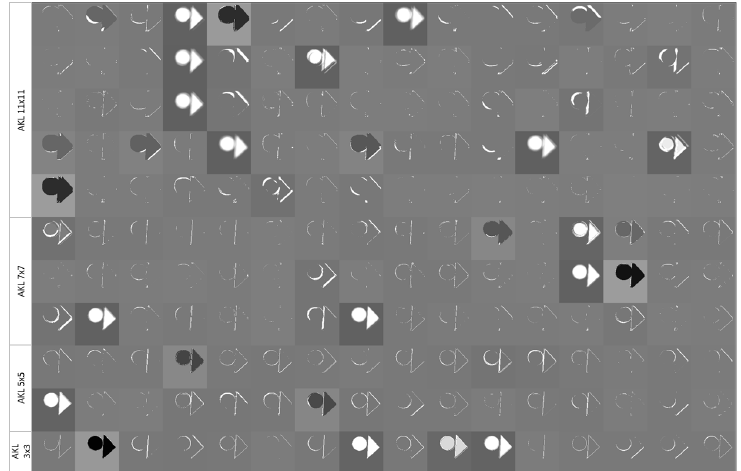
Figure 9. Sample output of the features learned by AKL’s kernels.